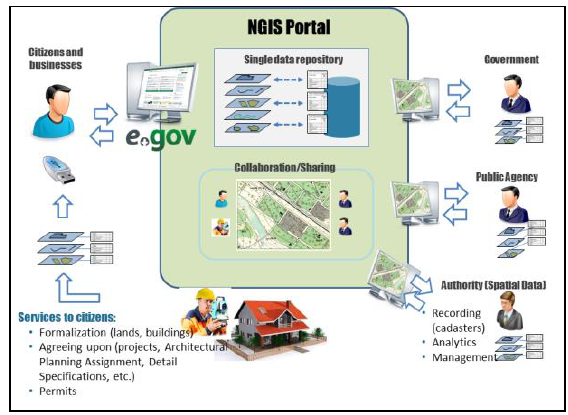
Figure 3. Concept of Kazakhstan NGIS Portal